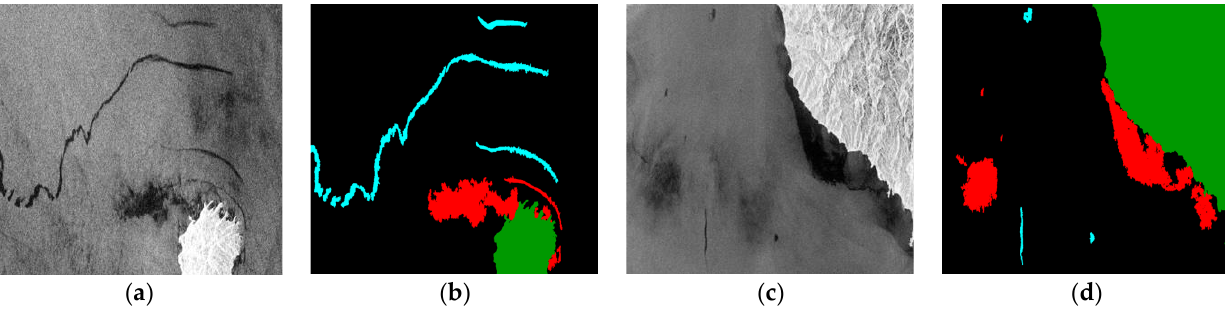
Figure 1. Two examples of source data, ( a , c ) are SAR images and ( b , d ) are ‘image-segmentation’ labels. Cyan corresponds to oil spills, red to look-alikes, brown to ships, green to land, and black is the sea surface.